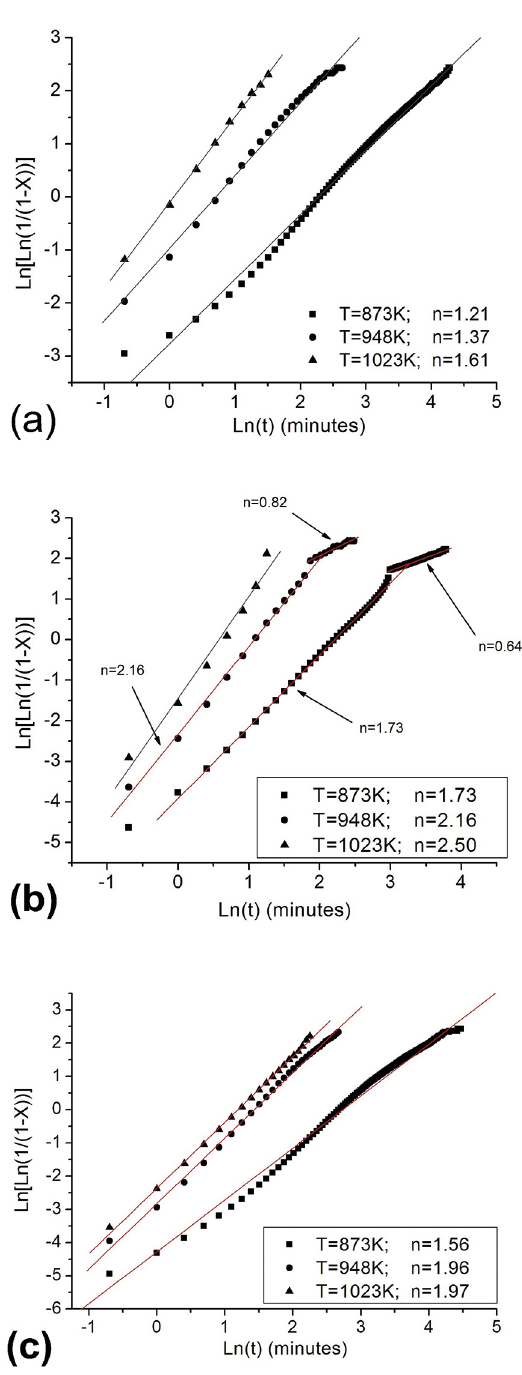
Figure 3: Avrami plots for temperatures 873 K, 948 K and 1023 K, from kinetics simulated by nucleation mechanisms of: site saturation (a), constant rate (independent of annealing temperature) (b) and temperature-dependent rate (c).